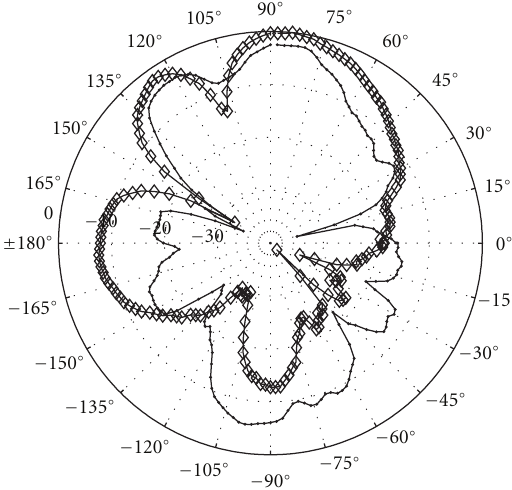
Figure 12: Normalized measured gain patterns for switched mode operation with ground plane-dotted markers for Yagi and diamond markers for V-shaped.